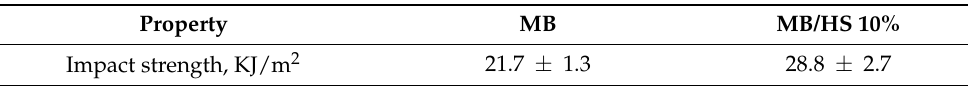
Table 3. Elastic modulus, tensile strength, and elongation at break of compression-molded and in- jection-molded MB and MB/HZ 10% samples.